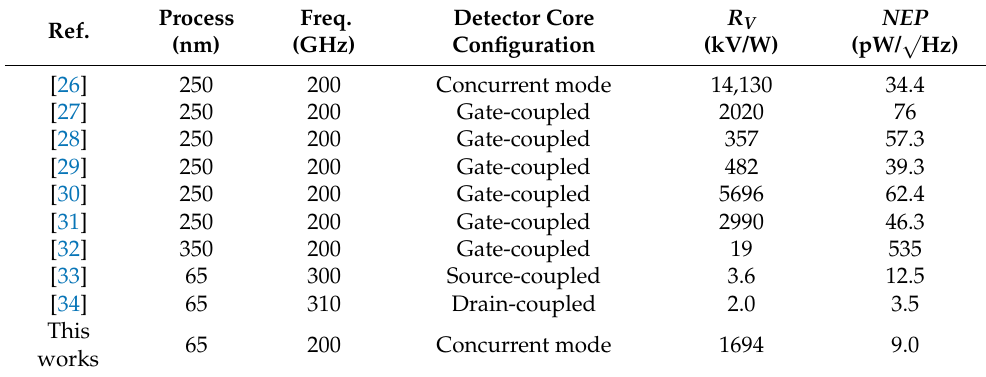
Table 1. Performance comparison of the 200 GHz CMOS detector-integrated circuits.